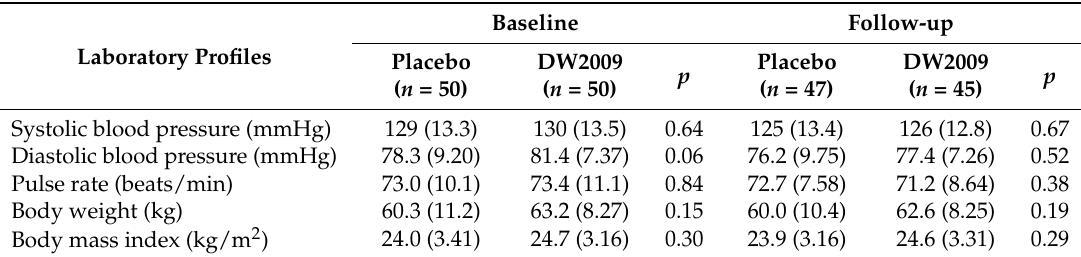
Table 4. Vital signs, body weight, and body mass index (BMI) of study participants assigned to the DW2009 and placebo